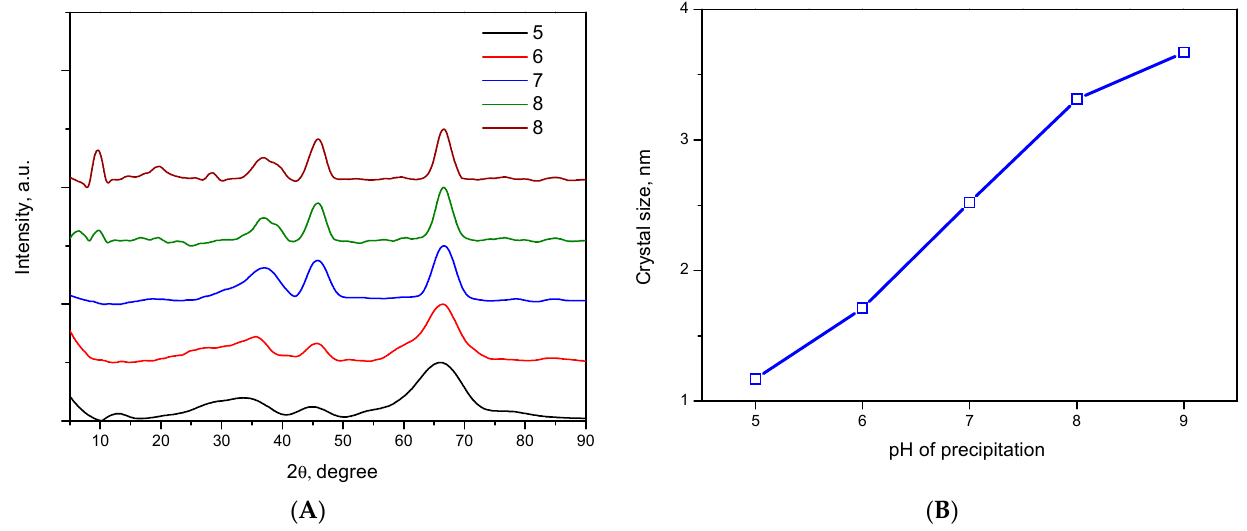
Figure 6. X-ray patterns of the samples ( A ): (5) Al-5; (6) Al-6; (7) Al-7; (8) Al-8; (9) Al-9 and the dependence of the crystal size on the pH of the precipitation ( B ).